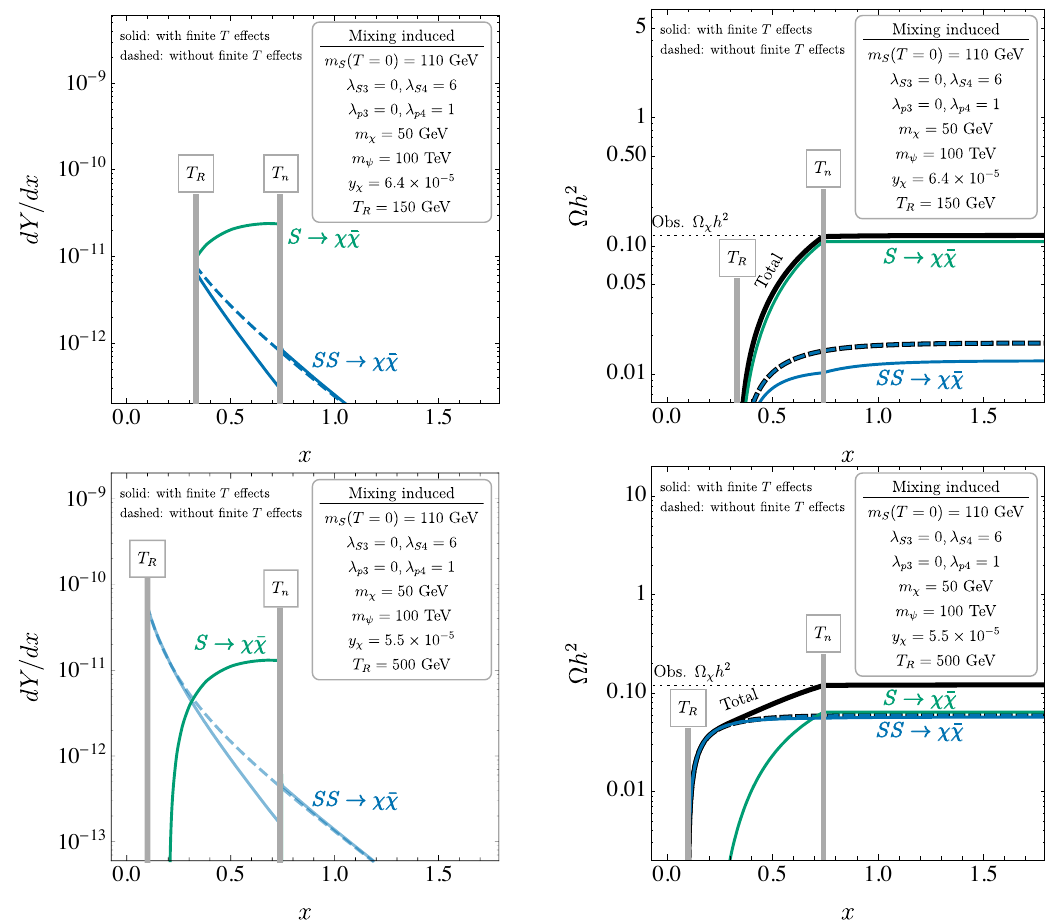
Figure 10 . Evolution of the DM production rate (left) and the DM abundance extrapolated to z = 0 (right) as a function of x (cid:17) m (cid:31) =T for two di(cid:11)erent parameter points in the mixing induced scenario from section 4. Solid curves correspond to the di(cid:11)erent production mechanisms shown in (cid:12)gure 9. The dashed curves indicates the result one would obtain if thermal corrections and the vev (cid:13)ip-(cid:13)op were neglected. We see that for a reheating temperature T R just above the electroweak scale (top panels), the DM abundance is dominated by the mixing-induced decay S ! (cid:31) (cid:22) (cid:31) , which is facilitated by the vev (cid:13)ip-(cid:13)op. For larger T R (bottom panels), the process SS ! (cid:31) (cid:22) (cid:31) , which